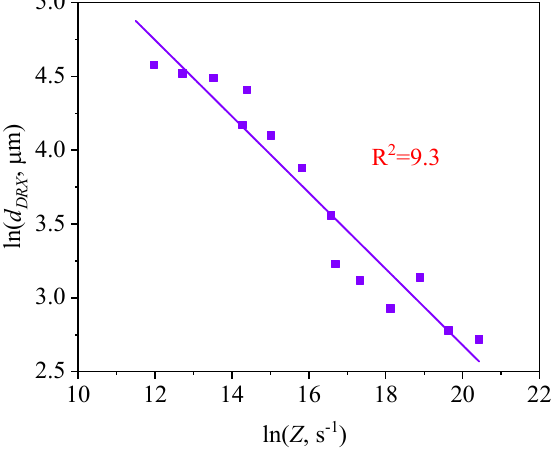
Figure 9. Relationship between ln DRX d and lnZ.